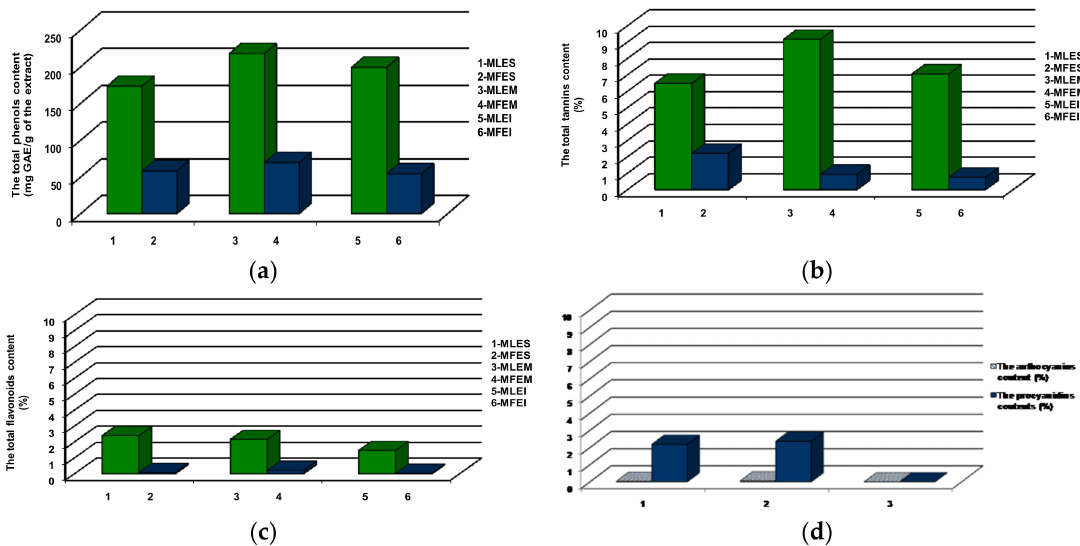
Figure 2. Content of ( a ) total phenolic compounds (TP); ( b ) total tannins (TT); ( c ) total flavonoids (TF); ( d ) total procyanidins and total anthocyanins in the investigated